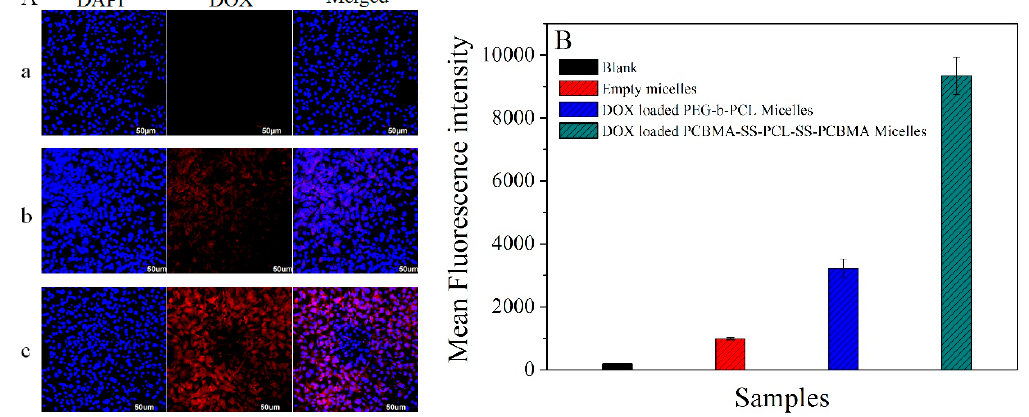
Figure 7 . Fluorescence microscopy images ( A ) of HepG2 incubated with empty micelles (a), DOX-loaded PEG- b -PCL micelles (b) and DOX-loaded PCBMA-SS-PCL-SS-PCBMA micelles (c) for 8 h; mean fluorescence intensity ( B ) of HepG2 cells treated by PBS, empty micelles, DOX-loaded PEG- b -PCL micelles and DOX-loaded PCBMA-SS-PCL-SS-PCBMA micelles, where DOX concentration was 6 mg/L. Data are presented as the average (standard deviation (n = 3)).